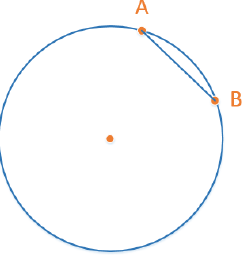
Figure 3. Arc-support line segment.